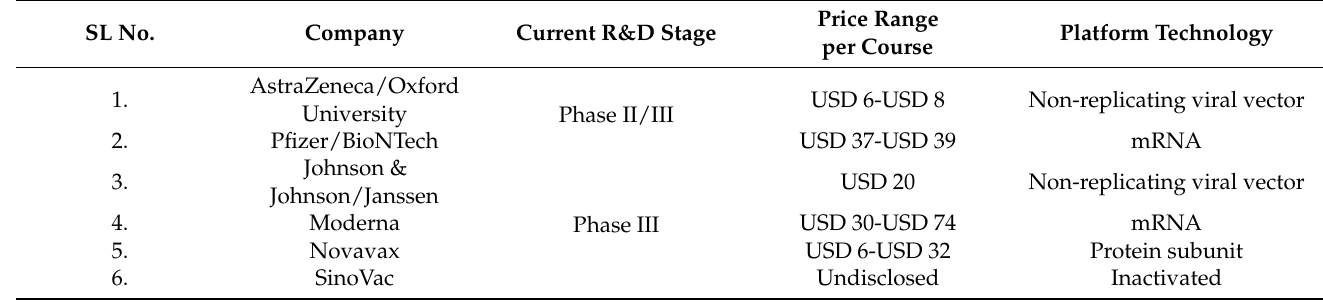
Table 12. Overview of leading companies with premarket price range